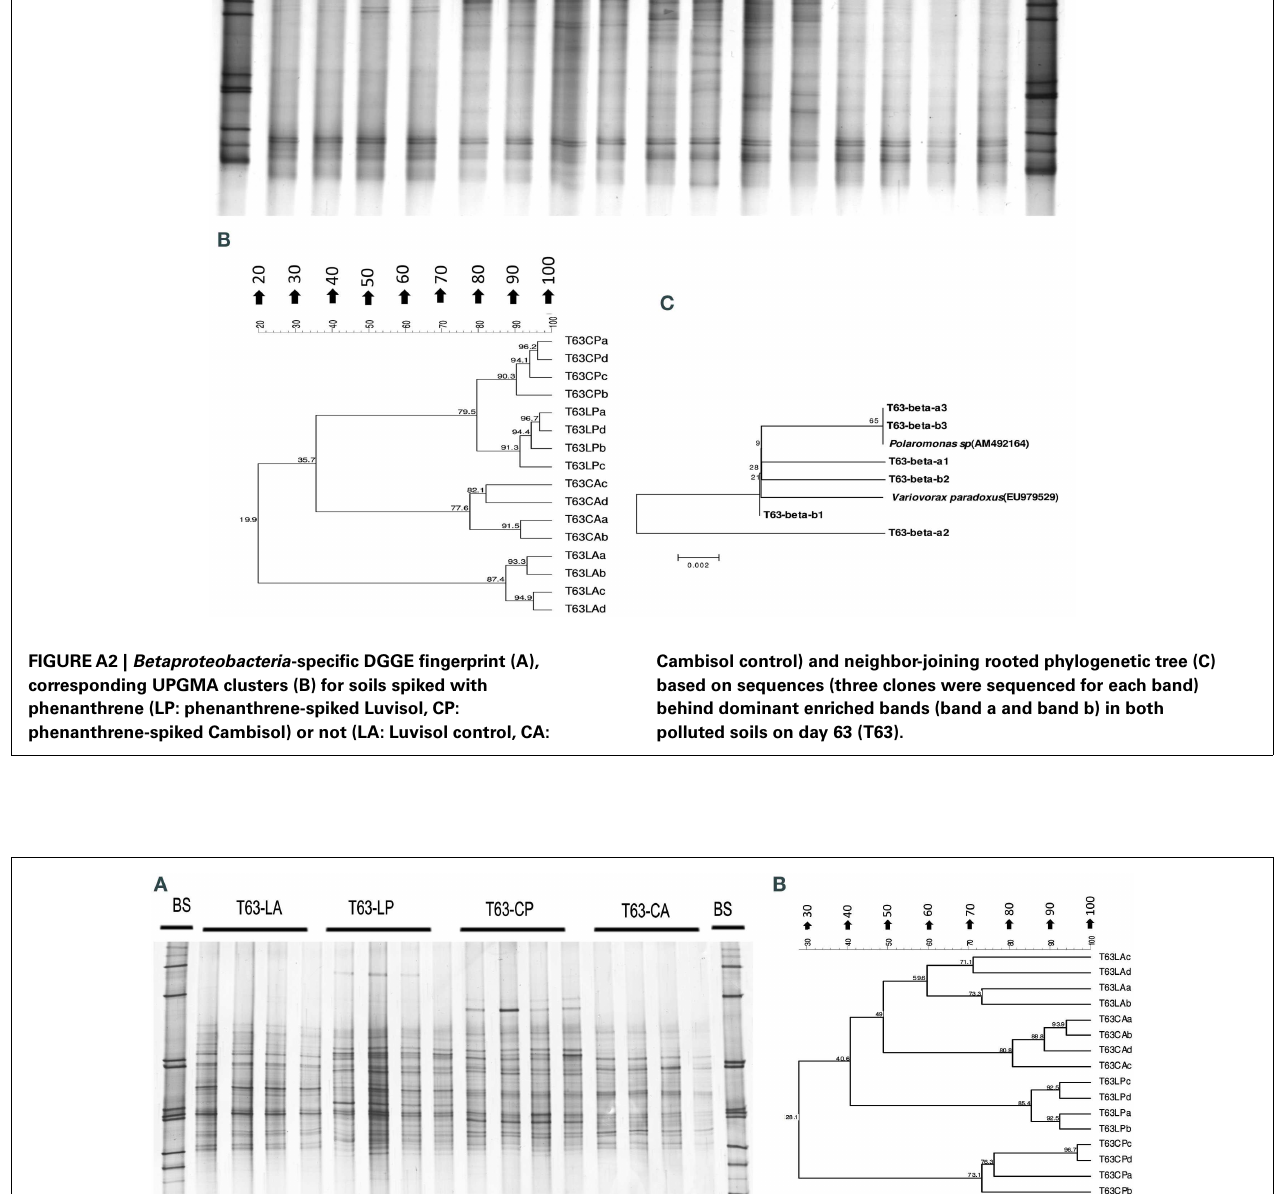
FIGUREA3 | Alphaproteobacteria -specific DGGE fingerprints (A) and the corresponding UPGMA clusters (B) for soil spiked with phenanthrene (LP: phenanthrene-spiked Luvisol, CP: phenanthrene-spiked Cambisol) or not (LA: Luvisol control, CA: Cambisol control) on day 63 (T63).